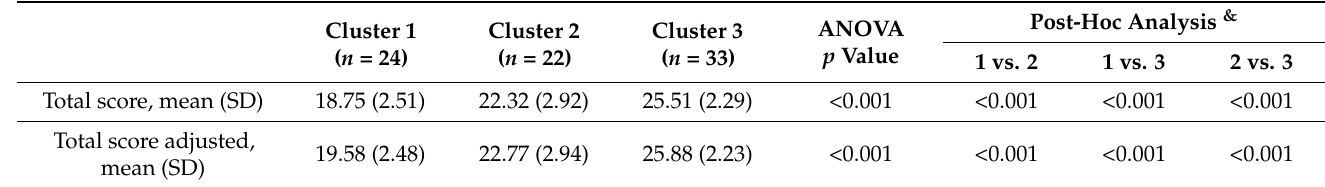
Table 4. Clusterts’ MoCA scores. Adjustments were made for educational levels ≤ 12 years according to the MoCA scoring